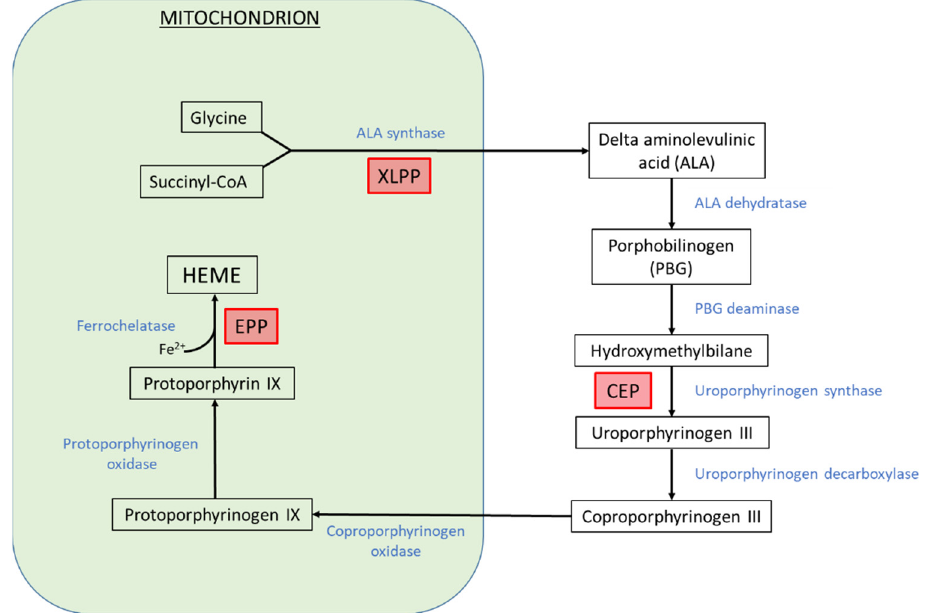
Figure 1. Heme biosynthesis pathway. Enzymes are indicated in blue. Erythropoietic porphyrias are indicated in red boxes in front of the corresponding enzyme dysfunction. CEP: congenital erythropoietic porphyria; EPP: erythropoietic protoporphyria; XLPP: X-linked protoporphyria.